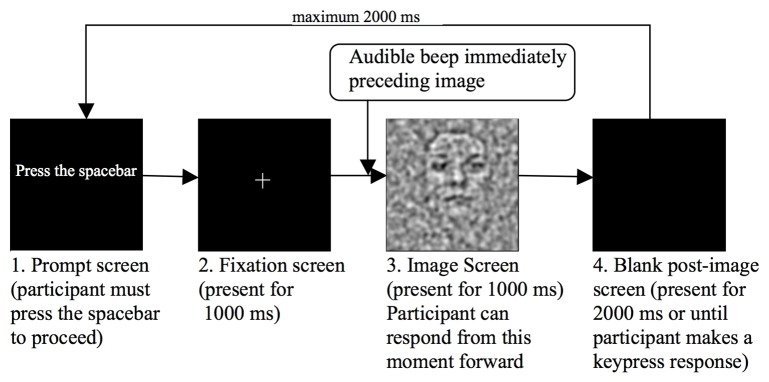
Schematic diagram of the presentation sequence for a single trial during the Perception Of Meaning task used in Experiment 2.